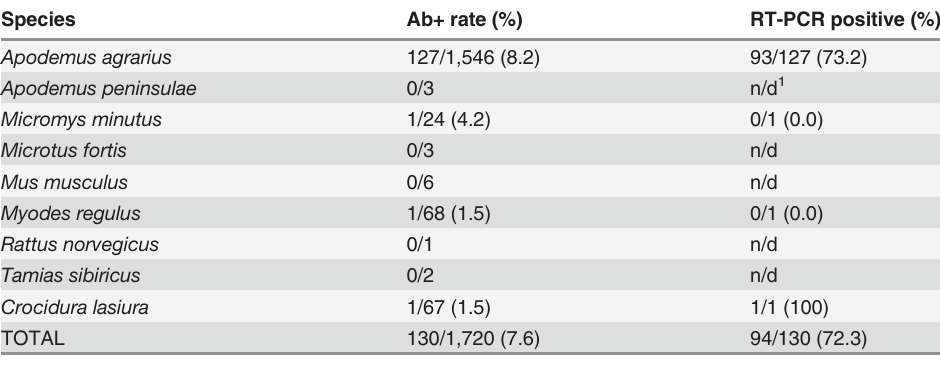
Table 1. Small mammals seropositive (%) for hantaviruses and positive (%) for Hantaan virus by re- verse transcriptase-polymerase chain reaction (rt-pcr) of lung tissues at Nightmare Range from Janu- ary 2008-December